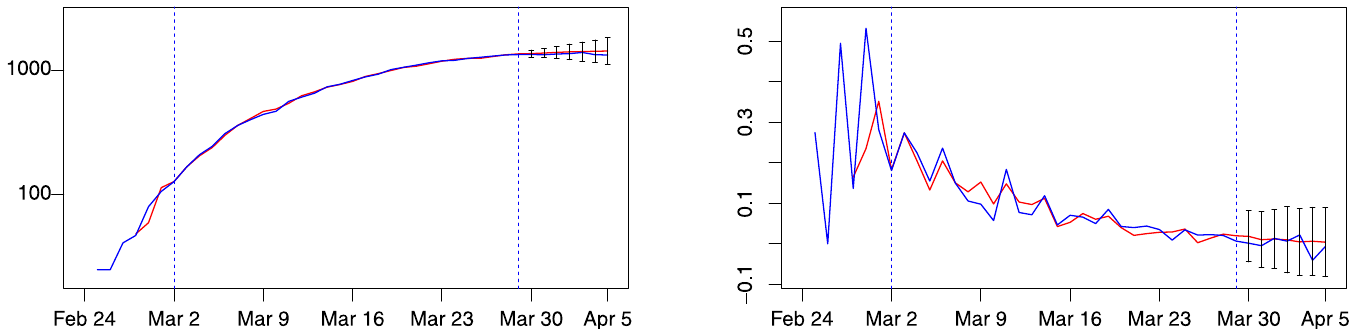
Fig 3. Lombardy forecast for week 6, model d (1, 1). Blue: actual; red: fitted (in estimation sample) or forecast (out-of-sample). Left: number of patients admitted in ICU. Right: % change of patients admitted in ICU. Estimation sample: March 2–March 29, between dashed vertical lines. Out-of-sample period: March 30–April 5. Forecast intervals ± 3 standard